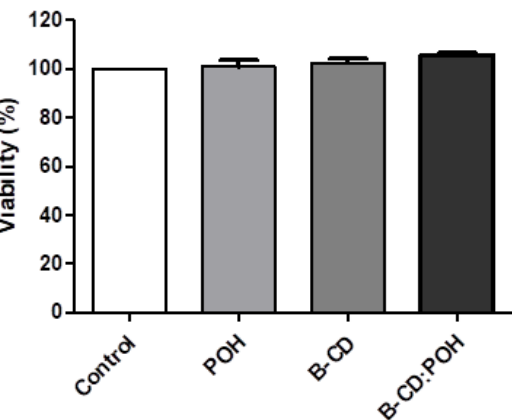
Figure 4. Effect of perillyl alcohol (POH), β -cyclodextrin and β -CD: POH (1:1) on the viability of human L929 fibroblasts determined by the MTT assay after 24 h of incubation. The negative control (C) was treated with the vehicle used to dissolve the drug (DMSO 5%). The data correspond to the mean ± S.E.M. of four independent experiments.